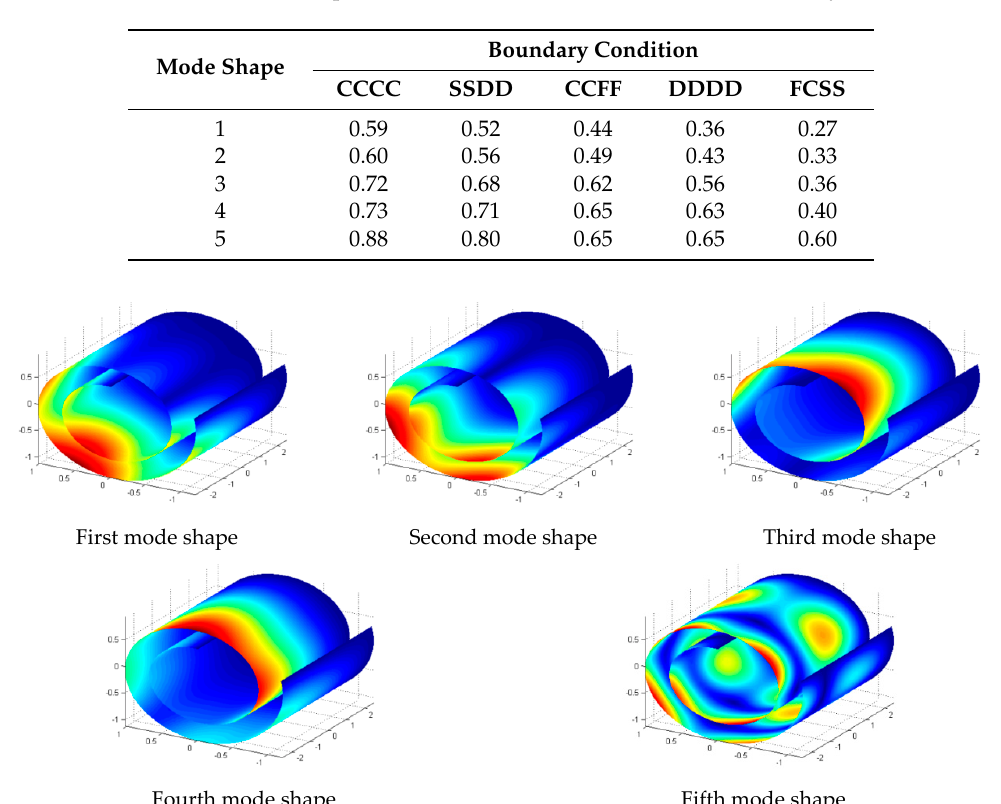
Figure 4 . First five mode shapes of the CNS with FCSS boundary condition. Figure 4. First five mode shapes of the CNS with FCSS boundary